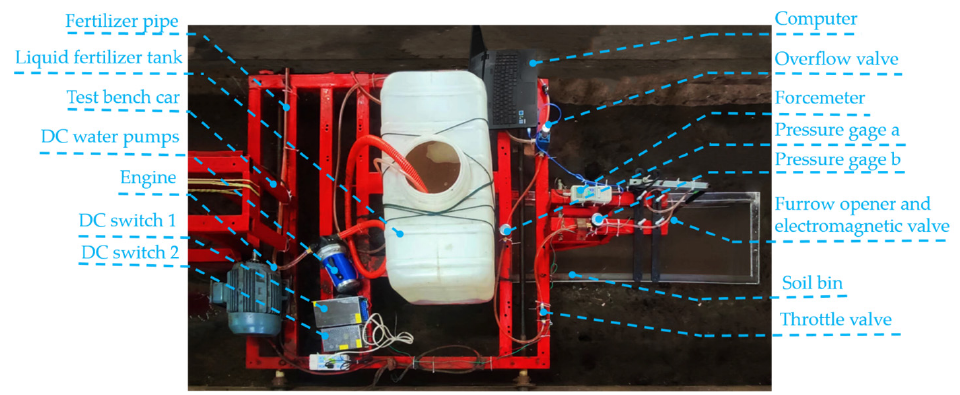
Figure 4. Test bench.